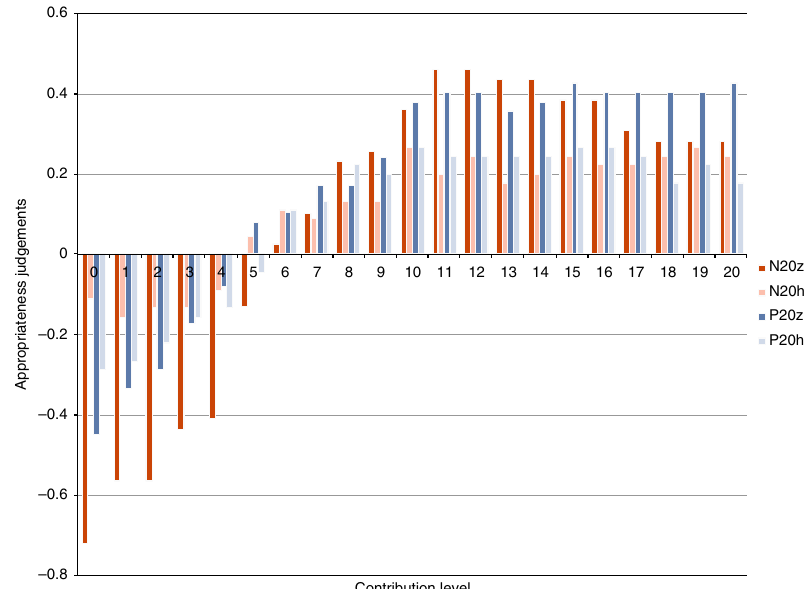
Fig. 3 Mean appropriateness scores for all contribution levels, for each treatment. In all treatments, subjects tend to judge contributions levels > 5 as appropriate and < 5 as inappropriate. Numerical scores are derived from a linear scaling of subject ’ s categorical responses on a Likert scale ranging from − 1 (very inappropriate) to +1 (very appropriate). N for the treatments: N20z = 26, N20h = 30, P20z = 29, P20h =